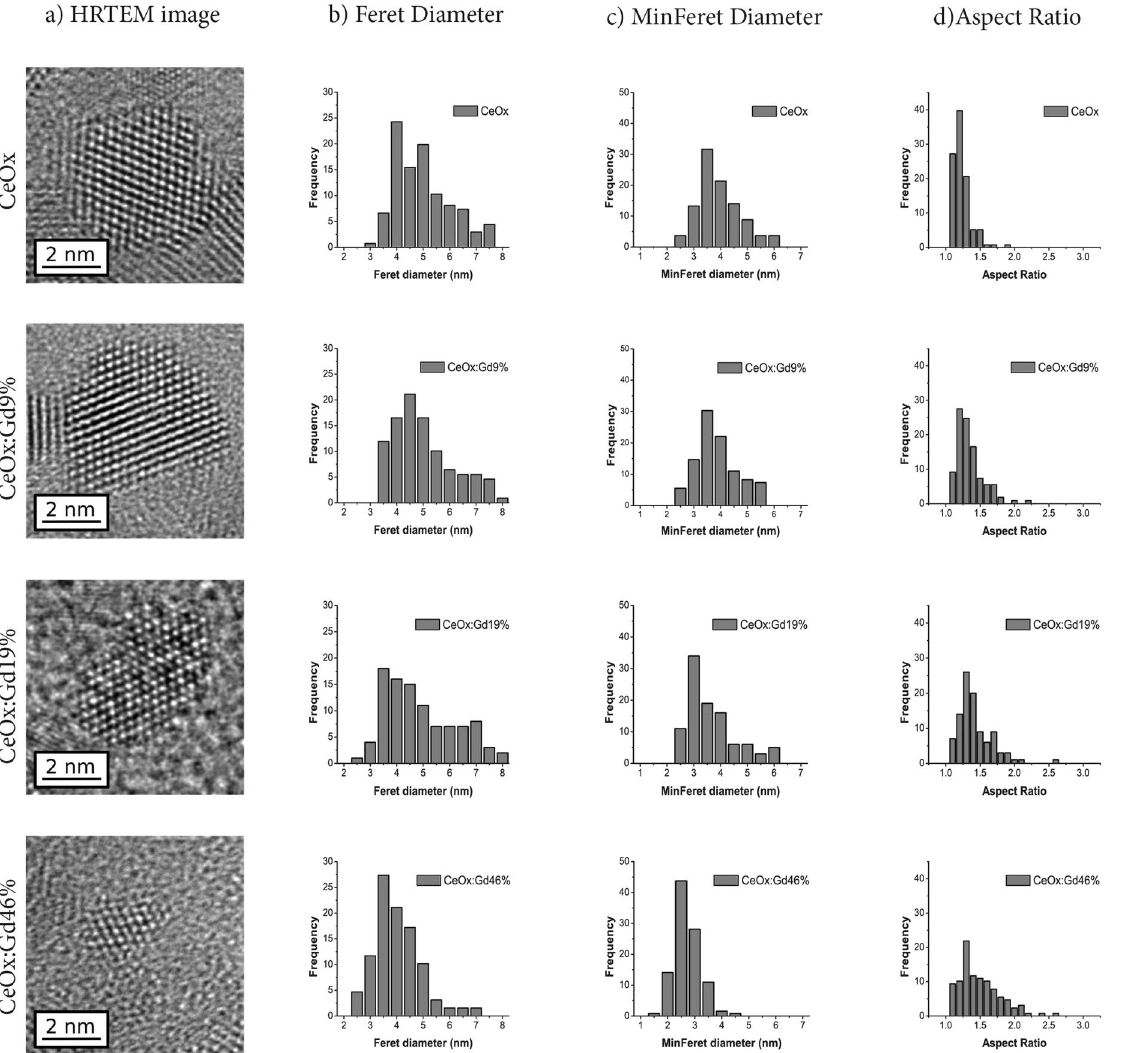
Figure 4. Representative HRTEM images of individual nanoparticles in (column a), distribution Feret Diameter of (column b), minimum Feret diameter (column c) and Aspect Ratio (column d) based on measurements from a minimum of 100 nanoparticles of respectively CeOx, CeOx:Gd9%, CeOx:Gd19% and CeOx:Gd46%. A full set of TEM images and size distribution for all samples (0%, 9%, 19%, 32%, 41%, 46%) are presented in supplementary